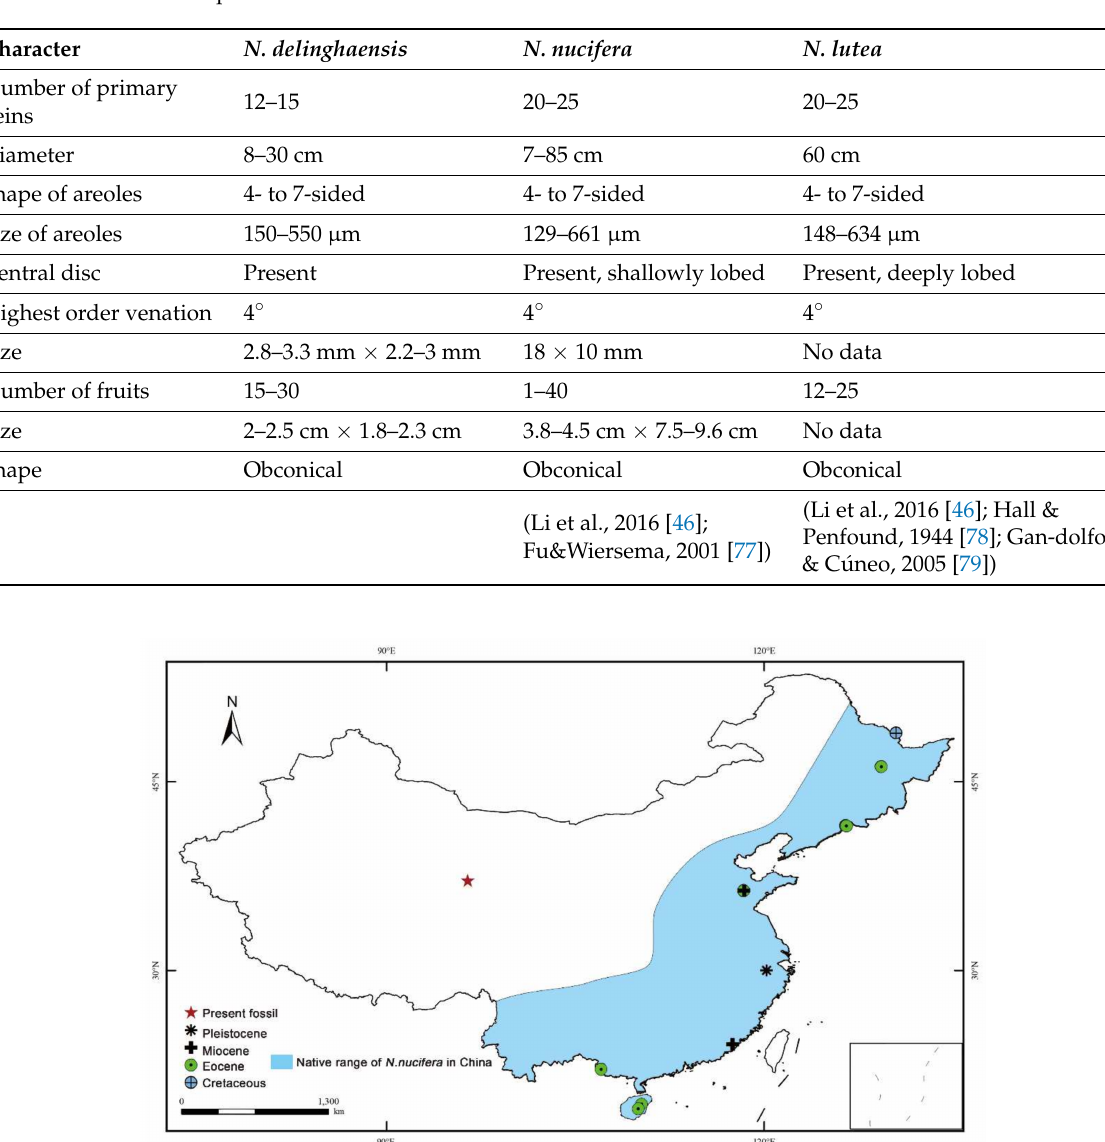
Table 2. Morphological comparison of leaves, receptacles and fruits in Nelumbo delinghaensis and extant species.